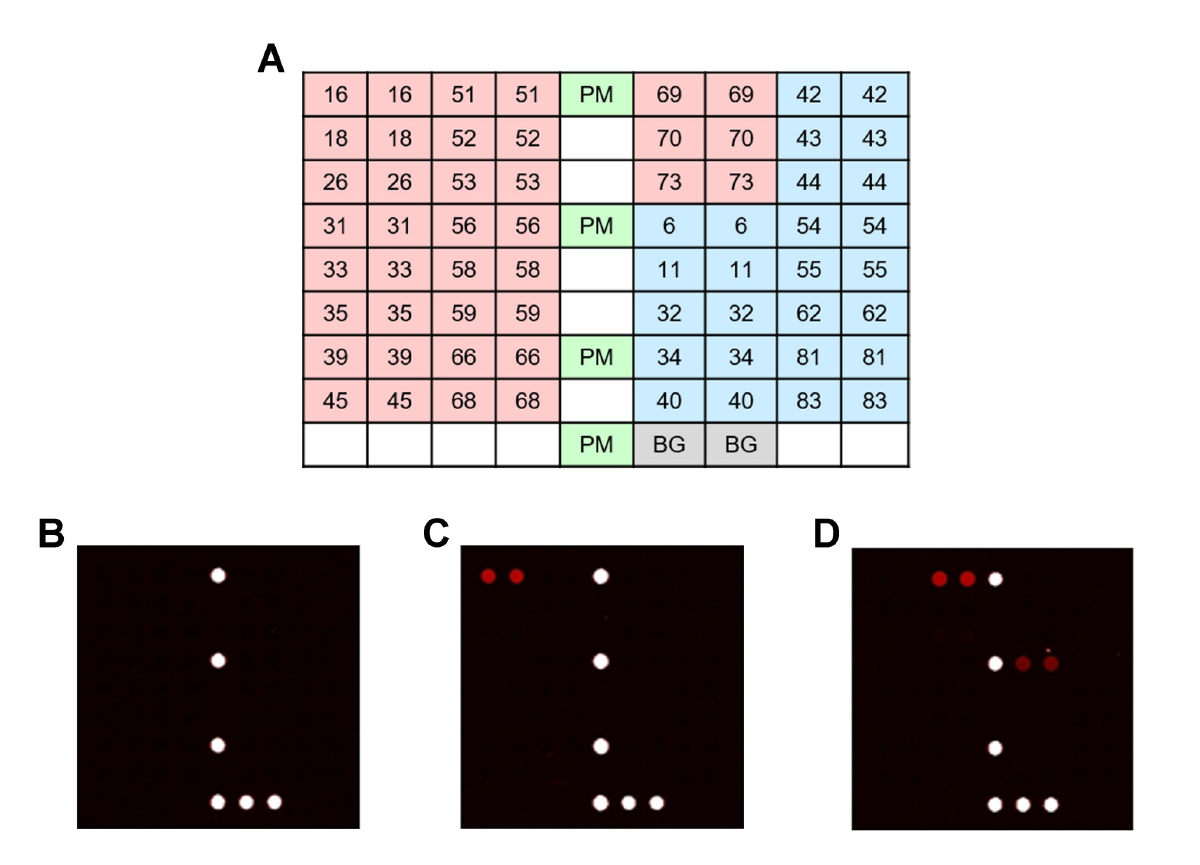
Fig 2. PANArray HPV. (a) The findings of 32 HPV genotypes containing 19 high-risk group (pink color) and 13 low-risk group (blue color) were spotted in duplicate with position marker (PM). ß-globin (BG) was amplified using PCR as an internal control. Representative scanning images of (b) negative control, (c) a single infection of HPV-16, and (d) double infections of HPV-6 and